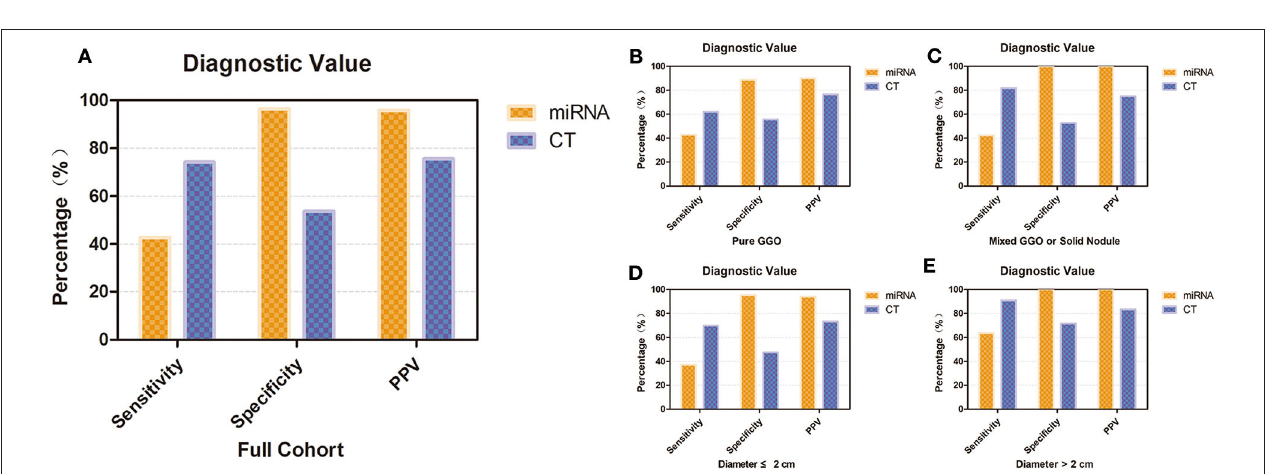
FIGURE 4 | Diagnostic value of the 12-miRNA panel compared with that of CT diagnosis. (A) Diagnostic value of the 12-miRNA panel compared with that of CT diagnosis in the whole validation group. (B) Diagnostic value of patients who have a pure GGO. (C) Diagnostic value of patients who have a mixed GGO or solid nodule. (D) Diagnostic value of patients whose nodule diameter was ≤ 2cm. (E) Diagnostic value of patients whose nodule diameter was larger than 2cm. CT, computed tomography; GGO, ground-glass opacity; PPV, positive predictive value; miRNA,